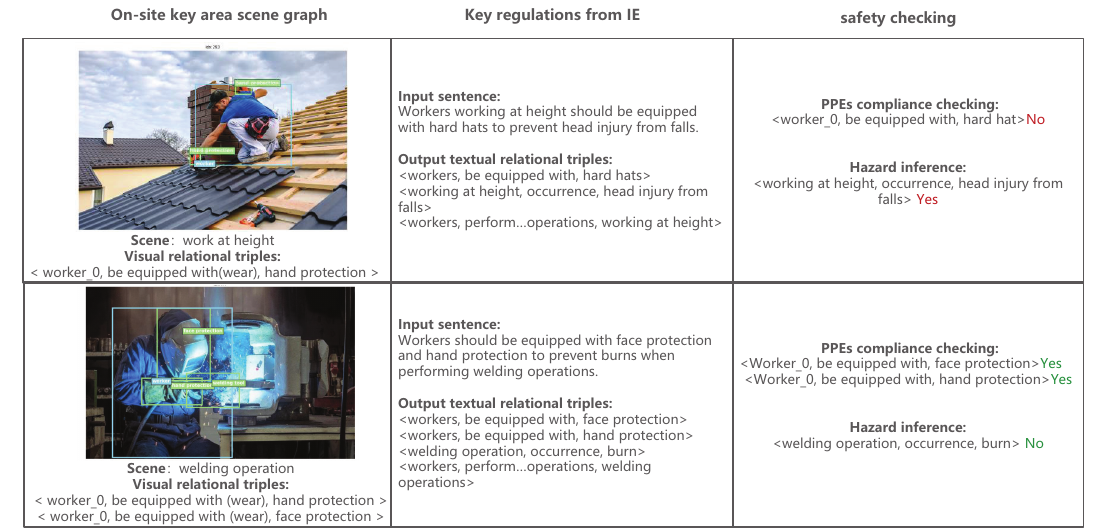
Figure 8. Examples of PPEs compliance checking and hazard